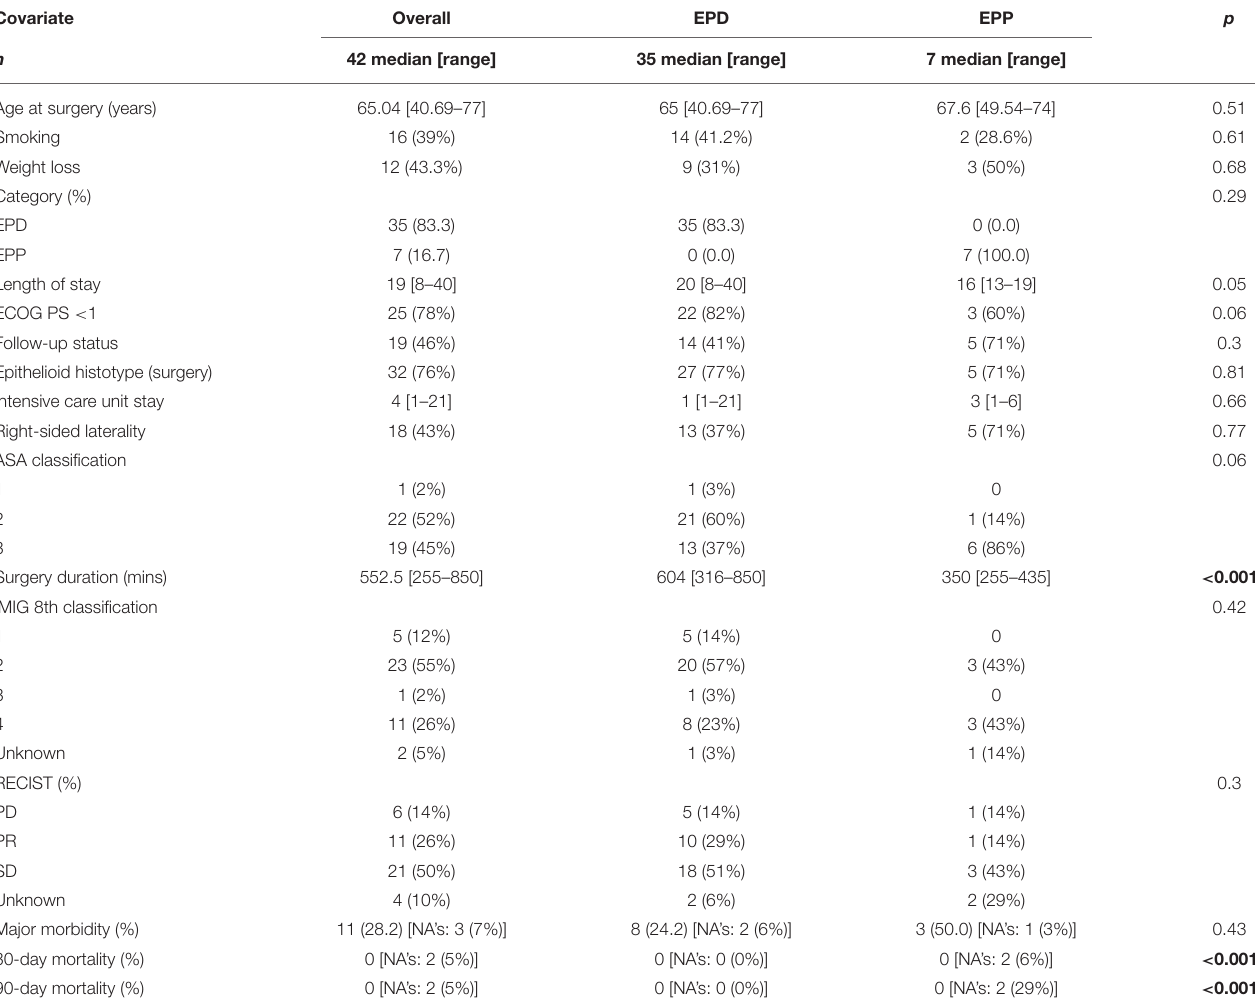
TABLE 1 | Patient’s characteristics and